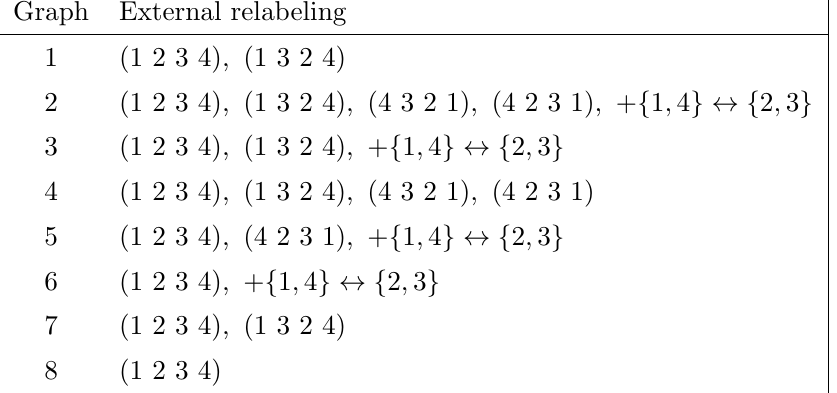
Table 1 . List of 27 cubic diagrams from relabeling of the eight graphs in (cid:12)gure 14. The right column gives all independent labels by exchanging the original external legs (1234) in each graph in (cid:12)gure 14. Here 1 ; 4 2 ; 3 means swapping 1 ; 4 with 2 ; 3 in all the previous labels. For f g $ f g example, this yields (2 1 4 3) and (2 4 1 3) for graph